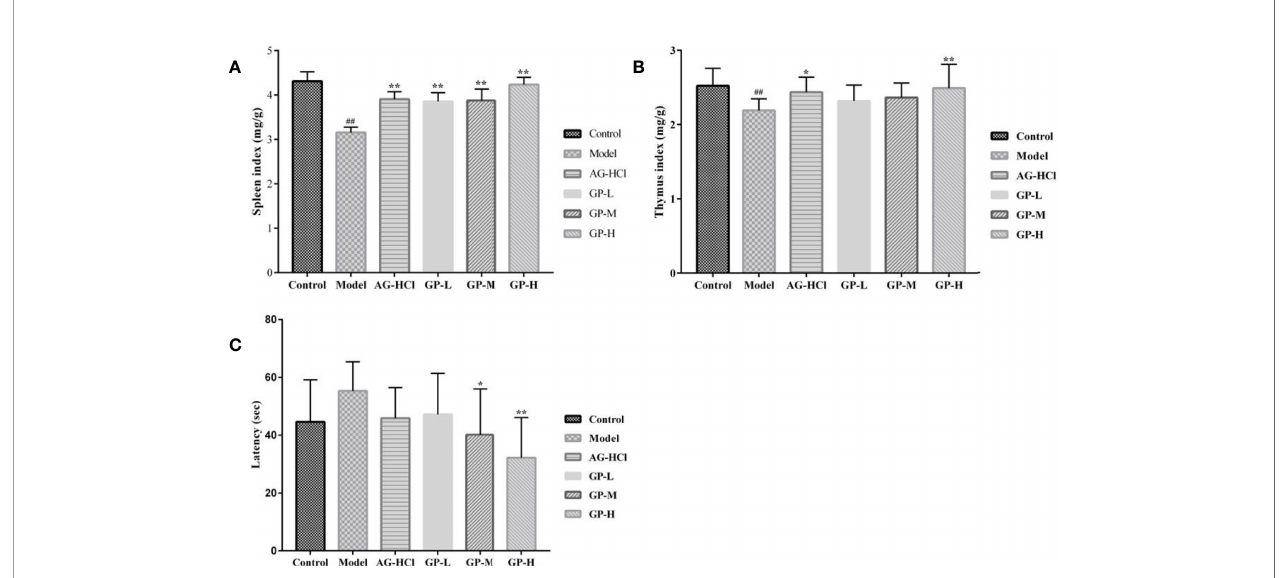
FIGURE 1 | Effects of GP onthe spleen index (A) , thymus index (B) andthe Morris latency (C) in mice (*p < 0.05, **p < 0.01 vsModel group;##p< 0.01 vsControl